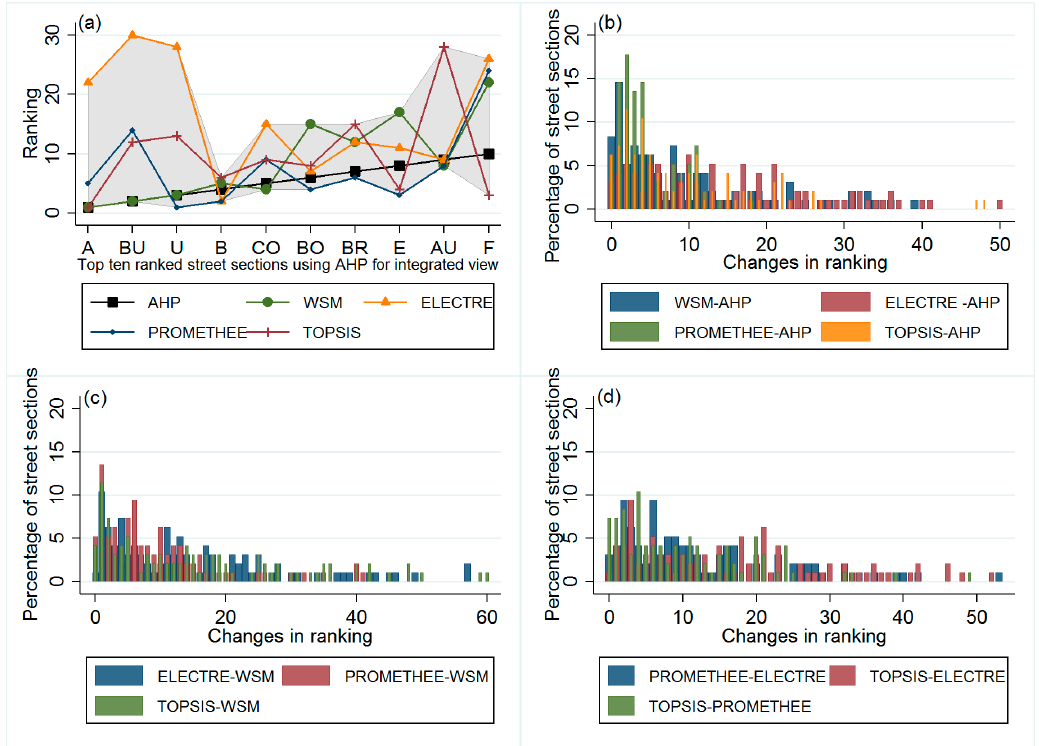
Figure 13. Comparison of the rankings of the integrated prioritization using the different methods: ( a ) for the 10 top ranked street sections; ( b ) the absolute ranking differences with the AHP; ( c ) the absolute ranking differences with the WSM; and ( d ) the absolute ranking differences with ELECTRE and PROMETHEE. Table 8. Standard deviation σ of the integrated ranking between the different used methods.